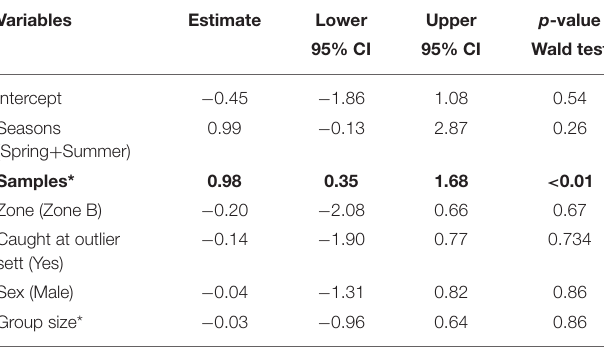
TABLE 3 | Average model coefficients and p -value of the Wald test calculated for variables included in top models ( 1 AICc < 4) explaining variation in bait uptake (detection of RhB in individual’s hairs) by captured badgers ( n =